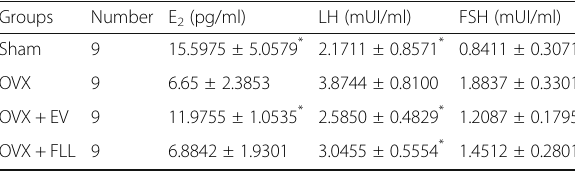
Table 2 Serum levels of E 2 , LH and FSH in the different groups of rats